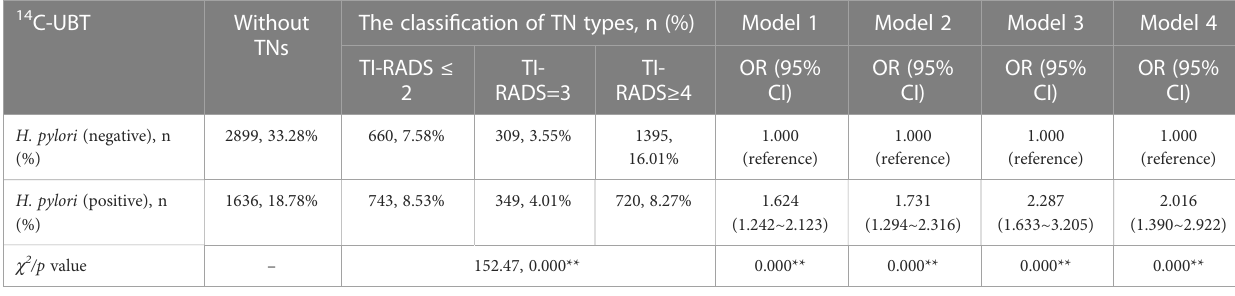
TABLE 2 The association between H. pylori infection and risk of TNs.